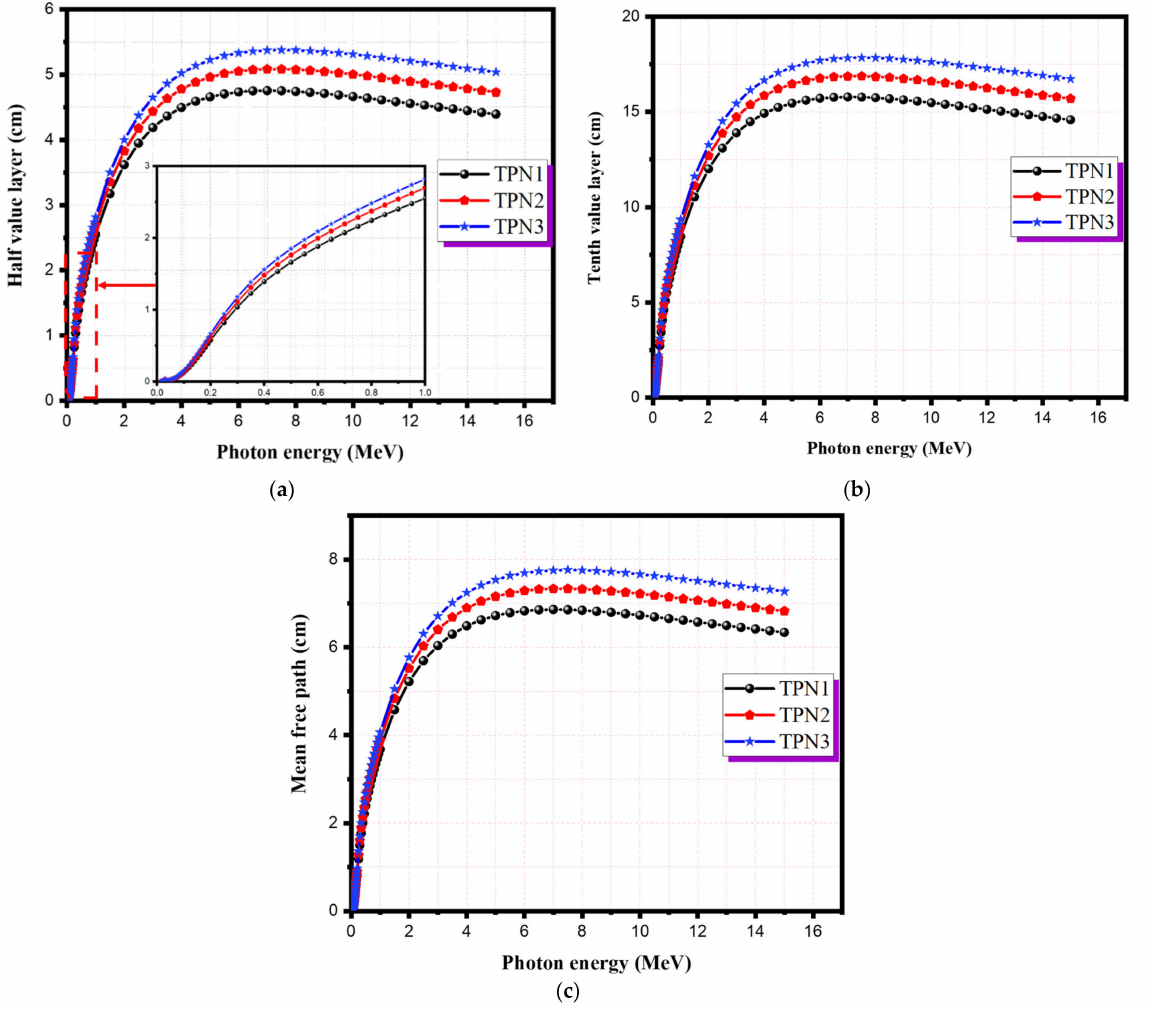
Figure 5. The shielding parameters of TPN systems: ( a ) HVL; ( b ) TVL; ( c )